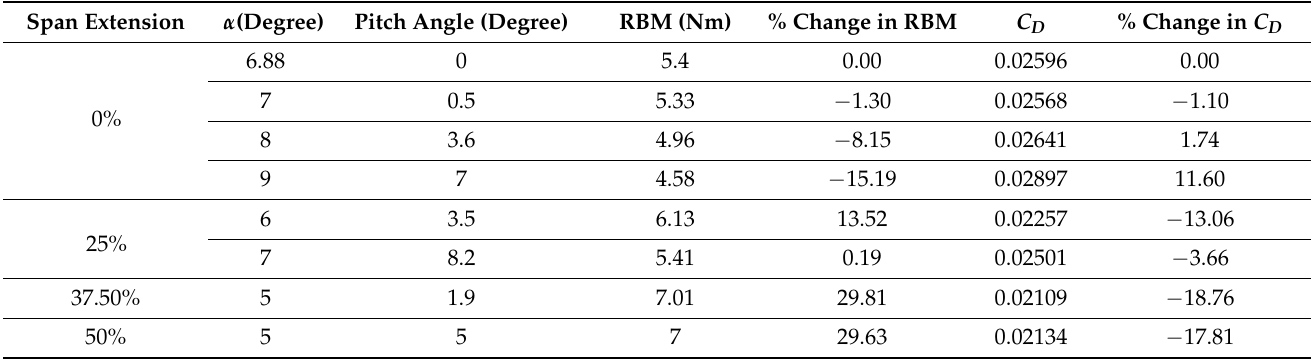
Table 1. RBM and C D for different span extensions at C L = 0.5. Reprinted/adapted with permission from Ref. [30]. 2021, American Institute of Aeronautics and Astronautics,